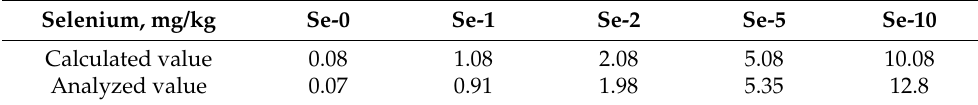
Table 2. The selenium level of experimental diets. Selenium, mg/kg